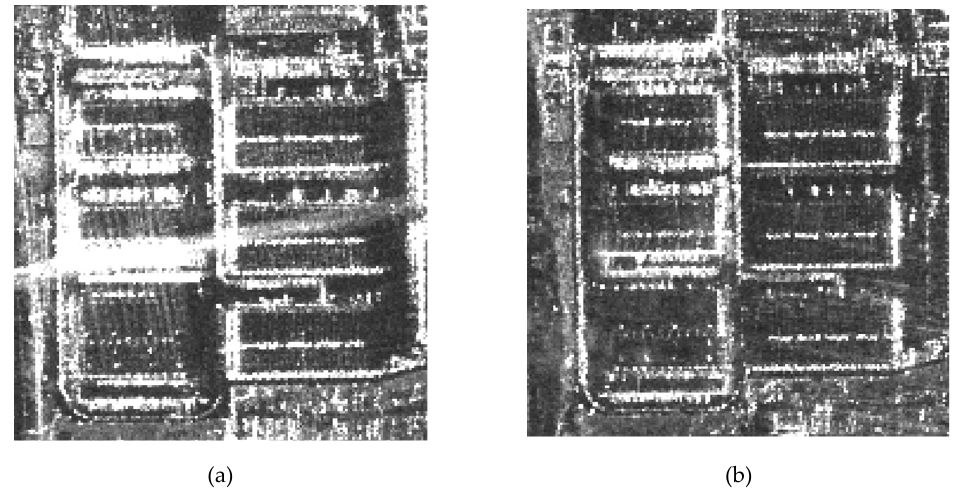
Figure 22. SAR images for different acquisition geometry: (a) ascending; (b) descending.